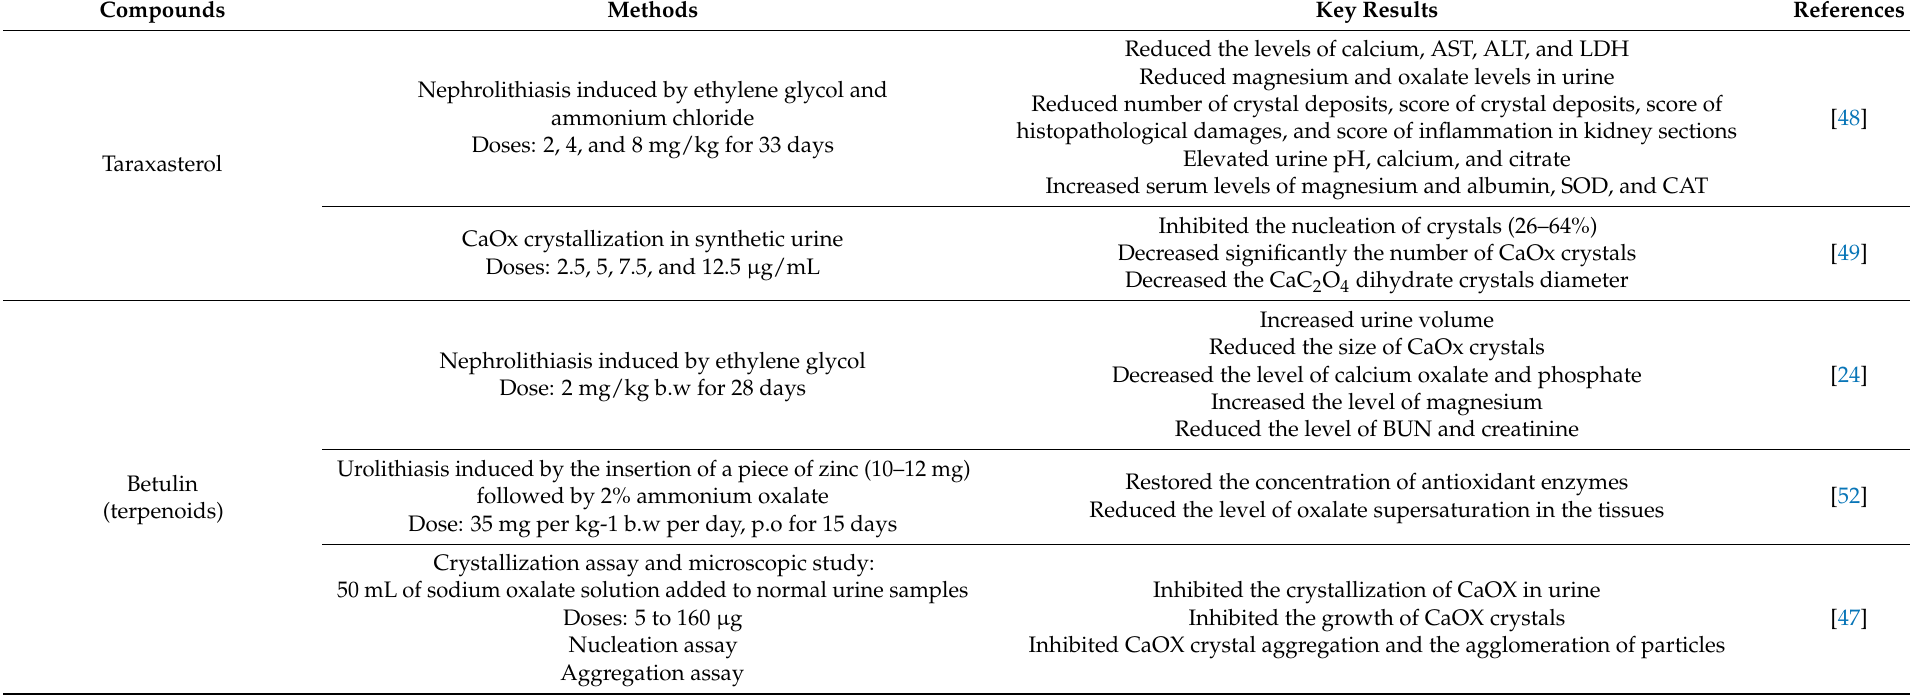
Table 4. Anti-urolithiasis effects of other